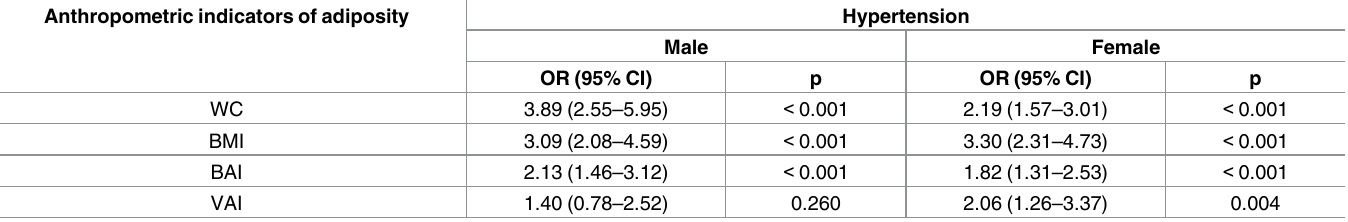
Table 3. Association between anthropometric indicators of adiposity and hypertension by logistic regression multivariate analysis in a Brazilian population. Anthropometric indicators of